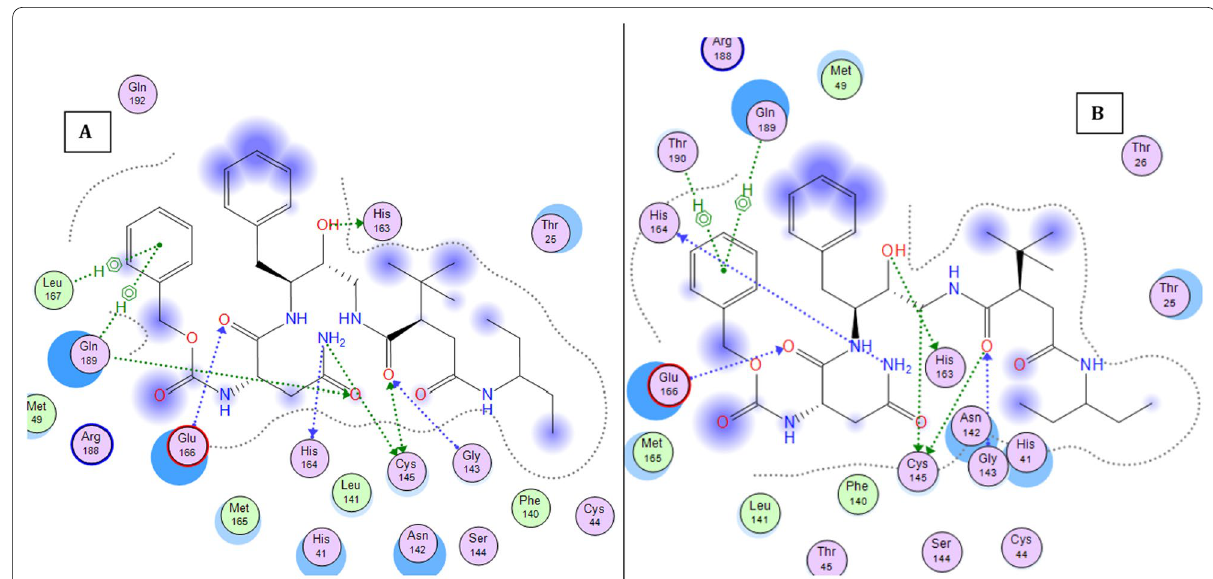
Fig. 13 2d interaction of inhibitor with Index number 847 A Before Molecular dynamics study and B After Molecular dynamics analysis